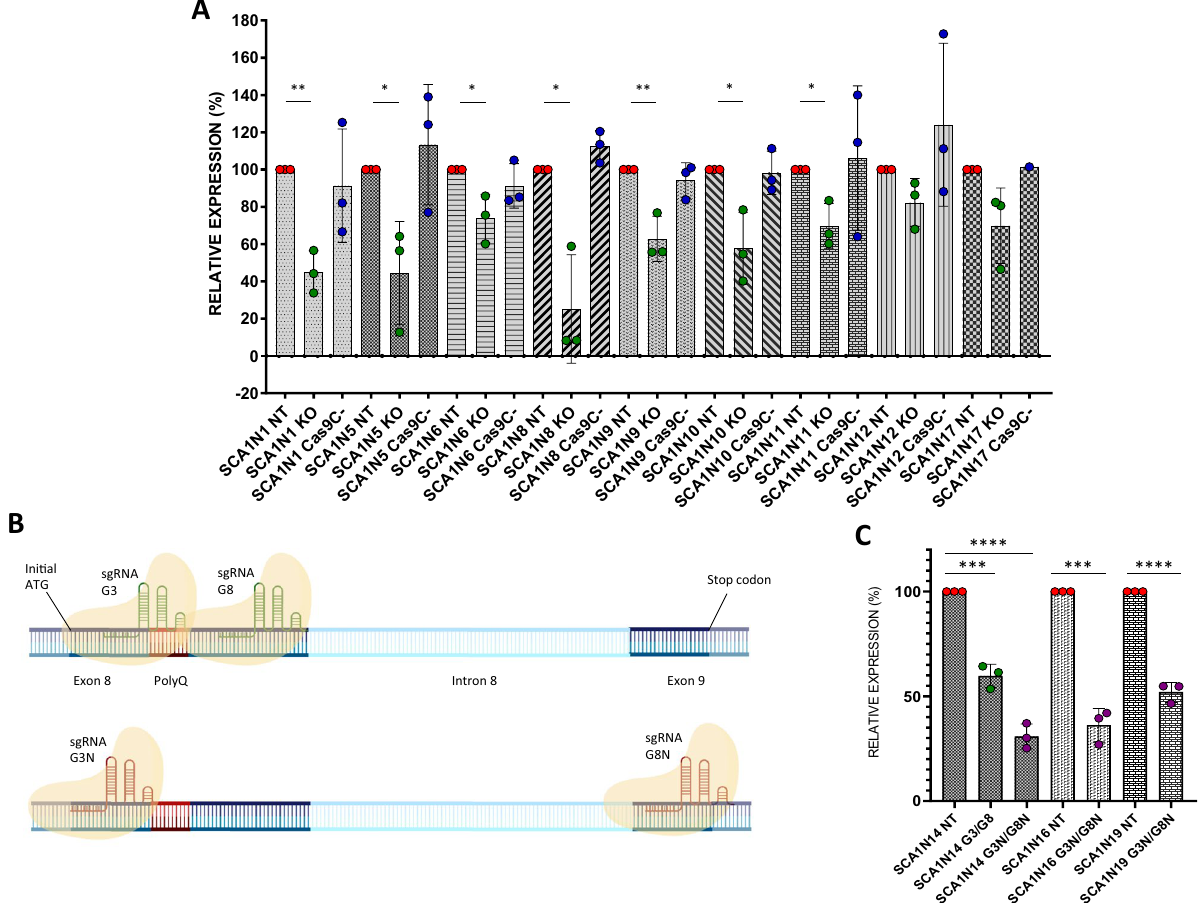
Figure 4. Effects of CRISPR/Cas9 systems in SCA1 fibroblasts. ( A–C ) ATXN1 expression in SCA1 fibroblasts. ( A ) Fibroblasts from nine SCA1 patients were treated using sgRNAs G3 and G8 complexed with Cas9 endonucleases. ( B ) Mapping of the sgRNAs’ target sequences: the sgRNAs G3 and G8 recognize target sequences respectively upstream and downstream of the polyQ tract, while the targets of G3N and G8N lie at the beginning of exon 8 and exon 9, respectively (created with BioRender.com). ( C ) SCA1N14 fibroblasts were treated using both sgRNAs G3 and G8 and sgRNAs G3N and G8N complexed with Cas9 endonucleases. SCA1N16 and SCA1N19 fibroblasts were treated using sgRNAs G3N and G8N complexed with Cas9 endonucleases. The ATXN1 expression was determined by Western Blotting. ATXN1 abundances were expressed relative to total proteins, determined by densitometry. Values are mean ± s.e.m. from three independent experiments. The statistical test used was unpaired t test with two-tailed P value and alpha level P < 0.05. *p < 0.05; **p < 0.005; ***p < 0.0005; ****p <